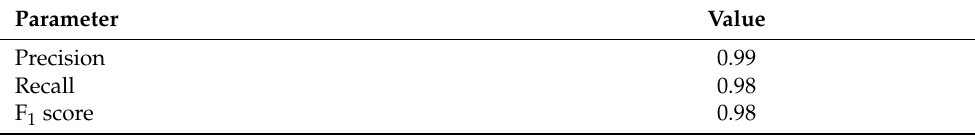
Table 8. Precision, recall and F 1 score of the PLS-DA model in the laboratory